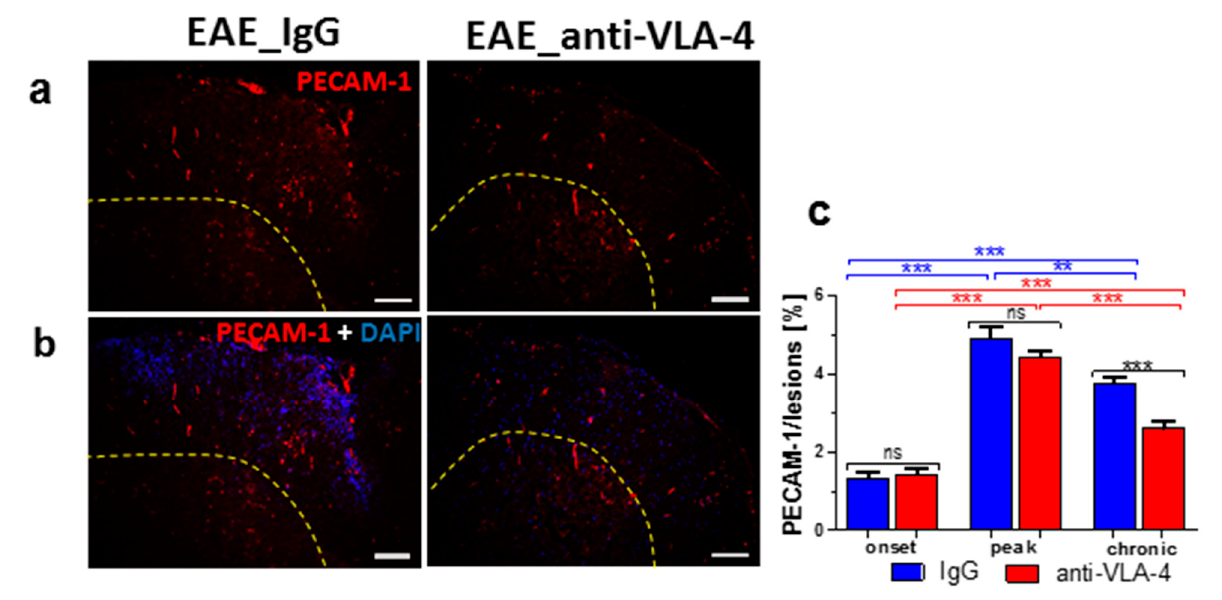
Figure 5. Immunostaining of PECAM-1 ( a ) and its overlapping fluorescence with DAPI ( b ) in cross-sectioned spinal cords of IgG- and anti-VLA-4-treated mice in the peak phase of EAE, as well as its quantitative measurements. PECAM-1 localization is associated with scarce cells and capillaries. Percentage values in ( c ) concern lesion area occupied by immunopositive structures. Data are presented as means ± SEM; n = 5 per group. Statistical significance was verified using a two-sided Mann–Whitney test at 0.05 confidence level (*** p < 0.001; ** p < 0.01; ns—not significant). Magnification is indicated by scale bars (=100 µm).